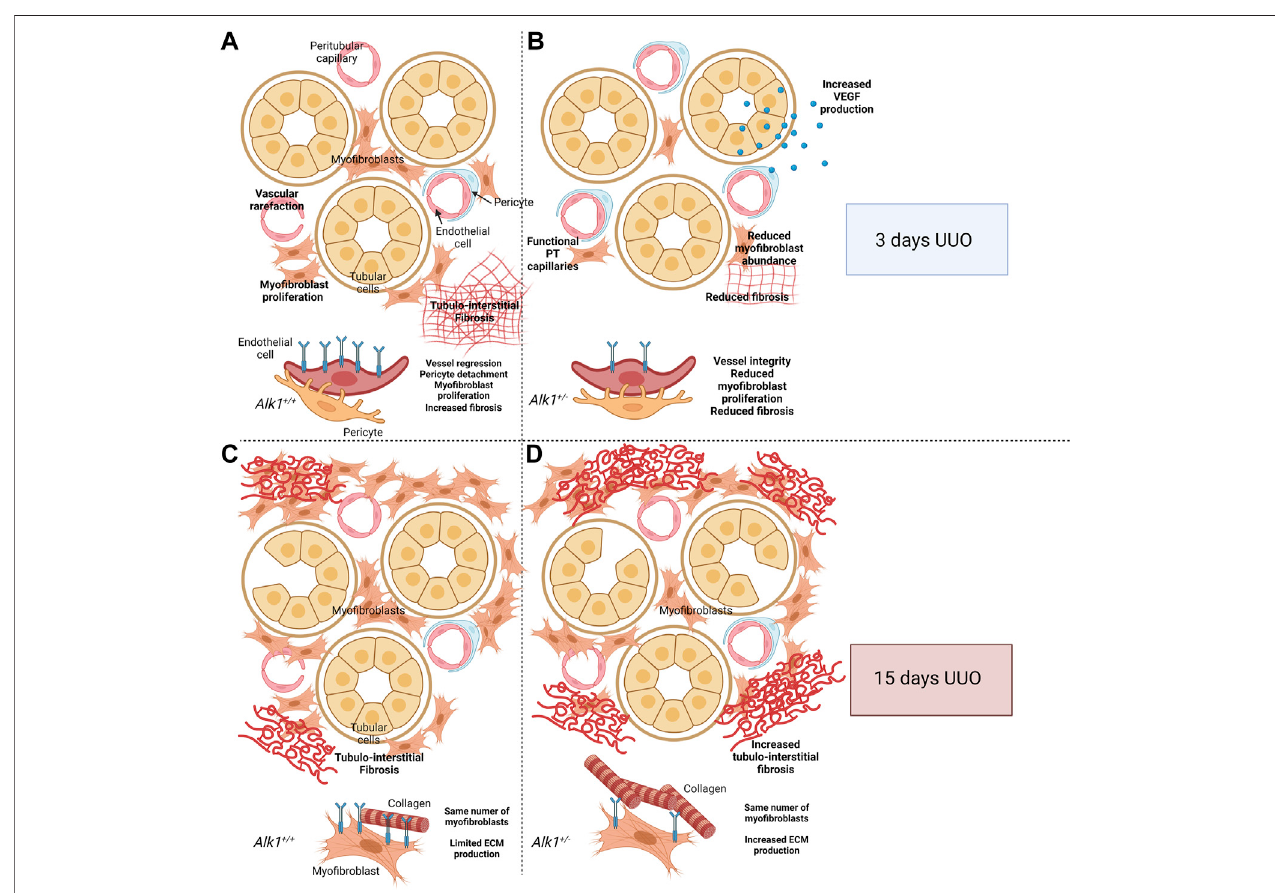
FIGURE 9 | Proposed cellular mechanism. After 3 days of Unilateral Ureteral Obstruction (UUO), myo fi broblasts emerge in the renal tubular interstitium and synthesize ECM proteins. At the same time, peritubular capillaries (PTC) undergo vascular rarefaction. This process starts with an angiogenic phase followed by a regression phase in which endothelial cells detach from pericytes and basement membrane, followed by apoptosis and leading to loss of functional capillaries. Both endothelialcellsandpericytescantransdifferentiateintomyo fi broblastsandactasasourceofextracellularmatrix(ECM)components (A,C) .ALK1heterozygosityis associated with PTC stability linked to an angiogenic process VEGF-dependent and the reduction of myo fi broblast abundance, leading to reduced tubule-interstitial fi brosis (A,B) Previousresultsfromourlaboratorydemonstratedthatafter15 daysofUUO, Alk1 +/+ and Alk1 +/ − miceshowthesamenumberofmyo fi broblastsbutthose from Alk1 +/ − mice produce higher amounts of ECM proteins leading to increased tubulointerstitial fi brosis (C,D) . Figure 9 was created using BioRender.com.